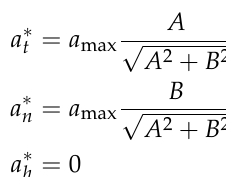
K for different inclination and 10